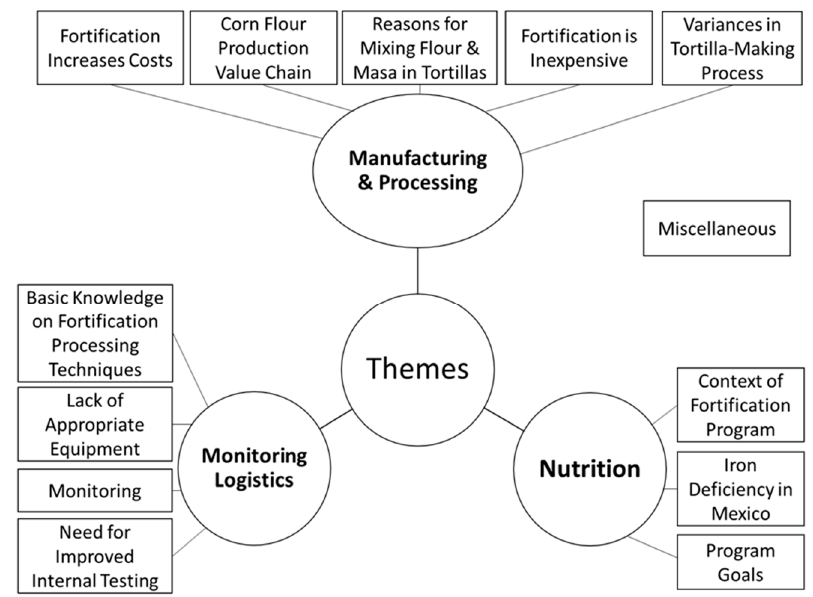
Figure 3. Thematic Map. Codes (n = 49) were grouped into concepts (n = 13, rectangular boxes in